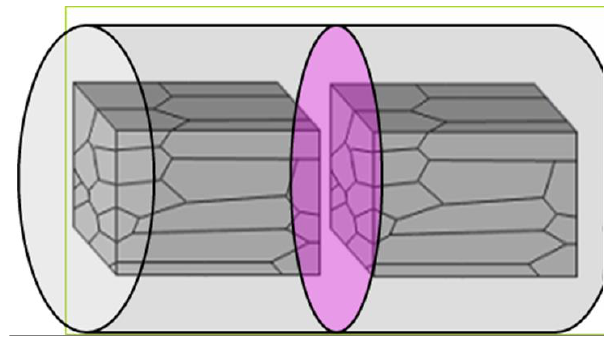
Figure 4. Diagram of the SPS joining orientation according to the sample orientation.